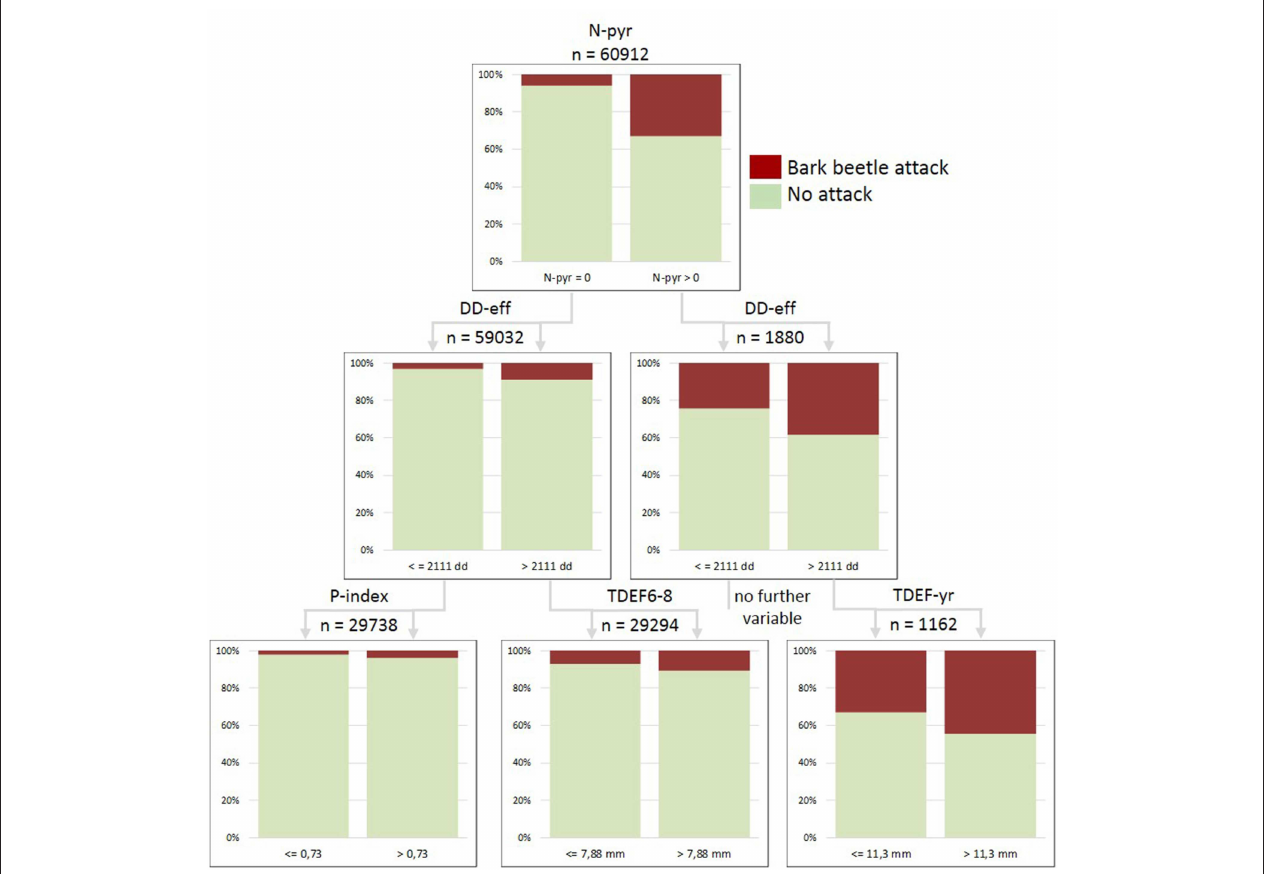
FIGURE 7 | Classification tree for the merged dataset of forest enterprises built for the year 2015 and including the variables: salvage loggings in the previous year (N-pyr), effective thermal sums for bark beetle development (DD-eff), stand predisposition index (P-index), transpiration deficits accumulated from June to August of the actual season (TDEF6-8), and transpiration deficits accumulated from January to December of the actual season (TDEF-yr). Total number of examined stands x observation years = 60,912; proportions of correct predictions: 93.1% in total, 5.8% presence of attacks, 99.5% absence of attacks.